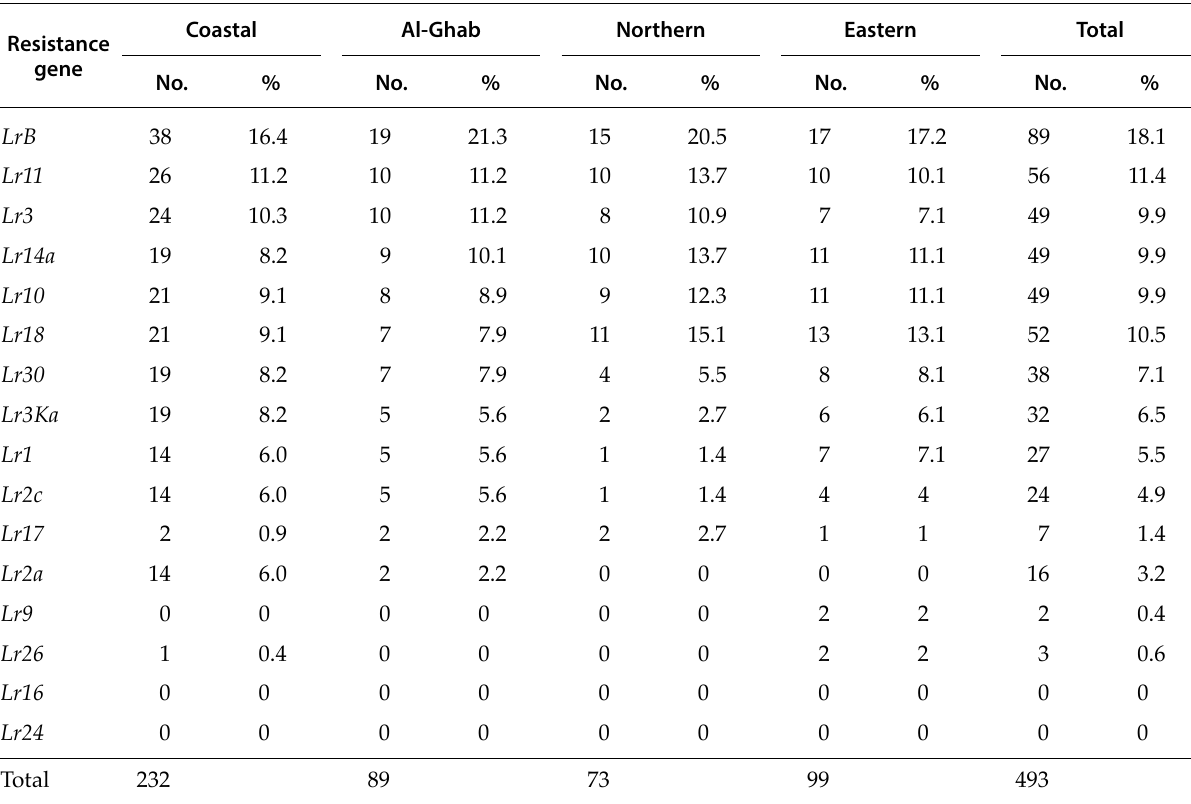
Table 2. Number and frequency (%) of isolates of Puccinia triticina in four Syrian regions in 2010 virulent to 16 lines of wheat with single resistance genes for leaf rust resistance. Coastal Al-Ghab Northern Resistance gene No. No.